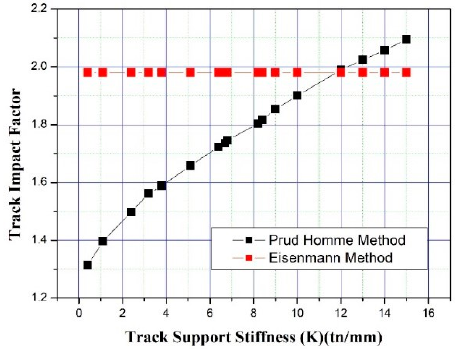
Figure 2. Correlation between Eisenmann and Prud’Homme method [19].